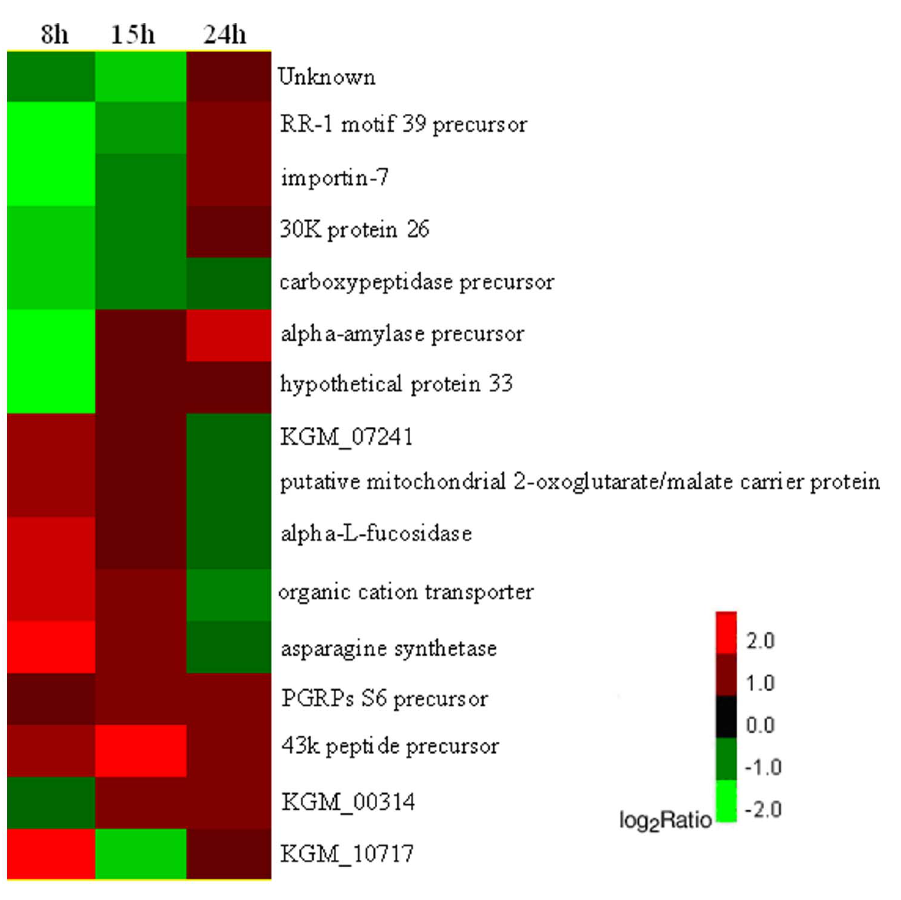
Figure 3. Clustering analysis of the intersection of DEGs in three time points. Each column represents a time point, each row represents a gene. Expressional differences are shown in different colors. Red means up-regulated and green means down-regulated.